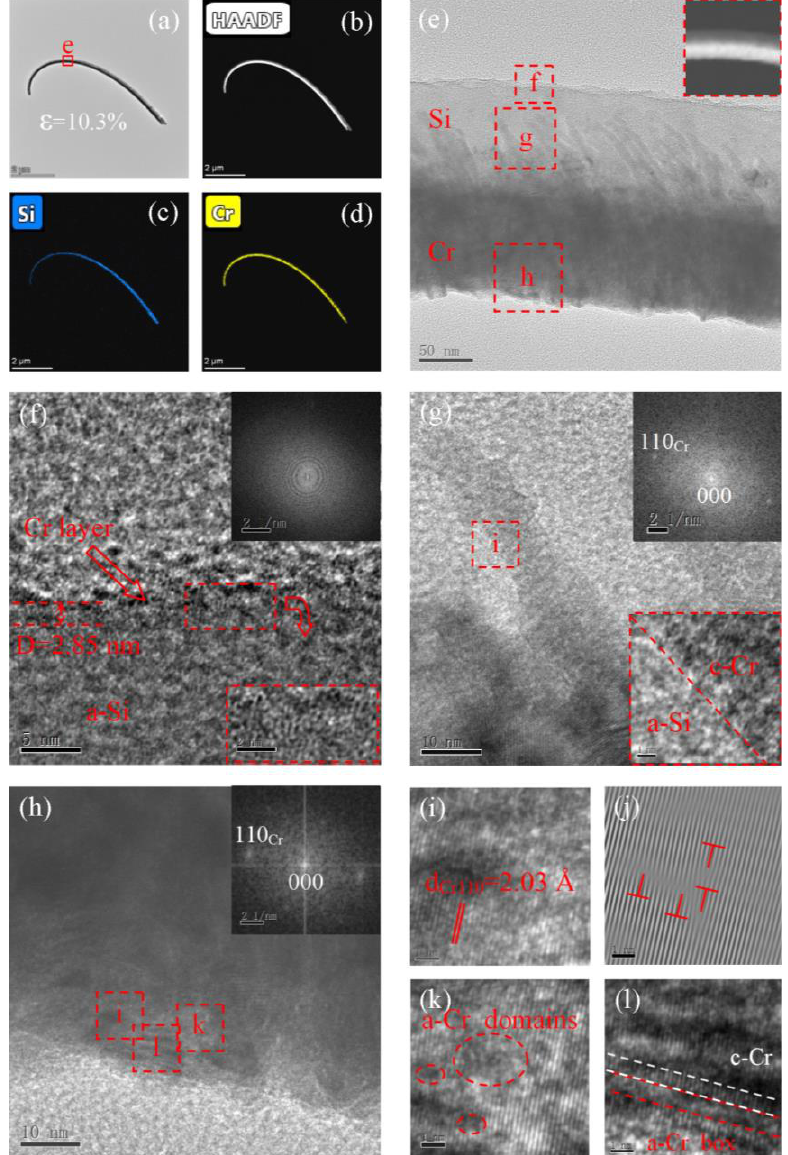
Figure 3. Bright-field TEM ( a , e ), HAADF ( b ), and STEM-EDX elemental mapping ( c , d ) images of Si NWs with 10.3% bending strain. HRTEM image of Si ( f ), Si/Cr interface ( g ), and asymmetric Cr ( h – l ). Panel ( j ) shows Fourier-filtered images. The insets of panels f – h display FFT patterns of Si, Si/Cr interface, and asymmetric Cr, respectively.